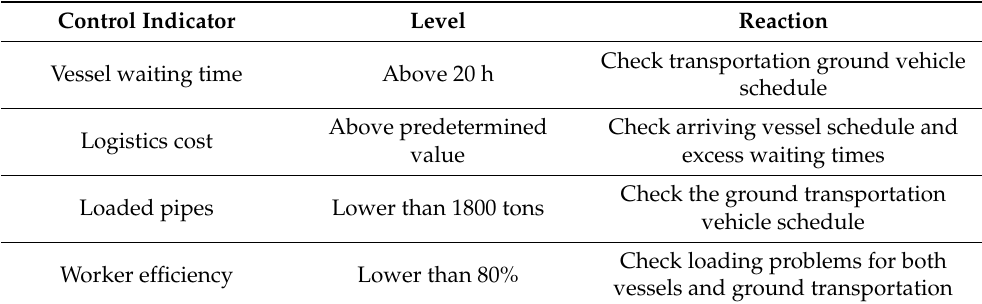
Table 1. Part of control indicators and